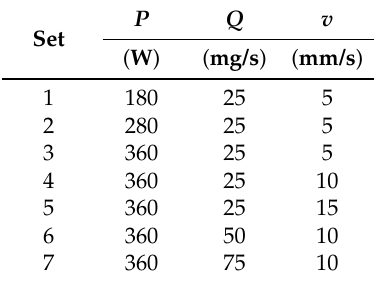
Table 2. Process parameter sets for each single track used for the model